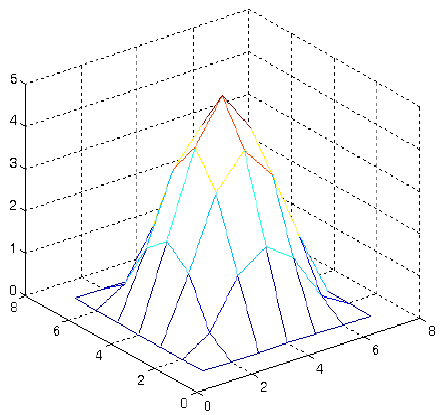
Figure 6. 3-dimensional map of kernel